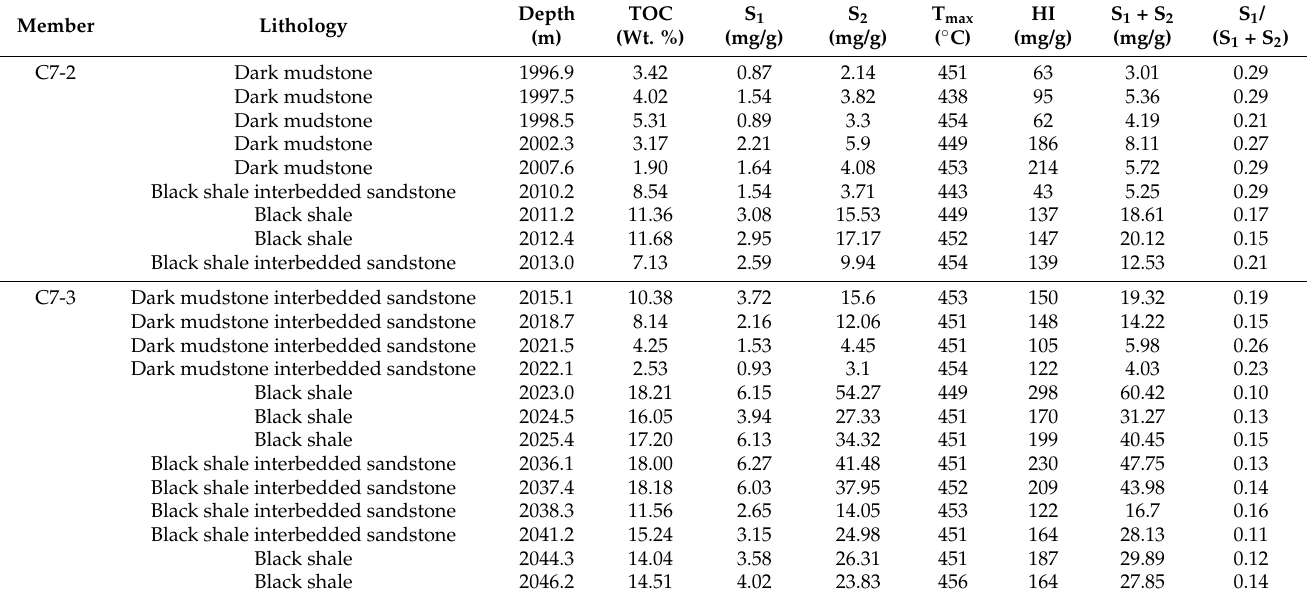
Table 1. Rock-Eval pyrolysis data of the source rock samples.